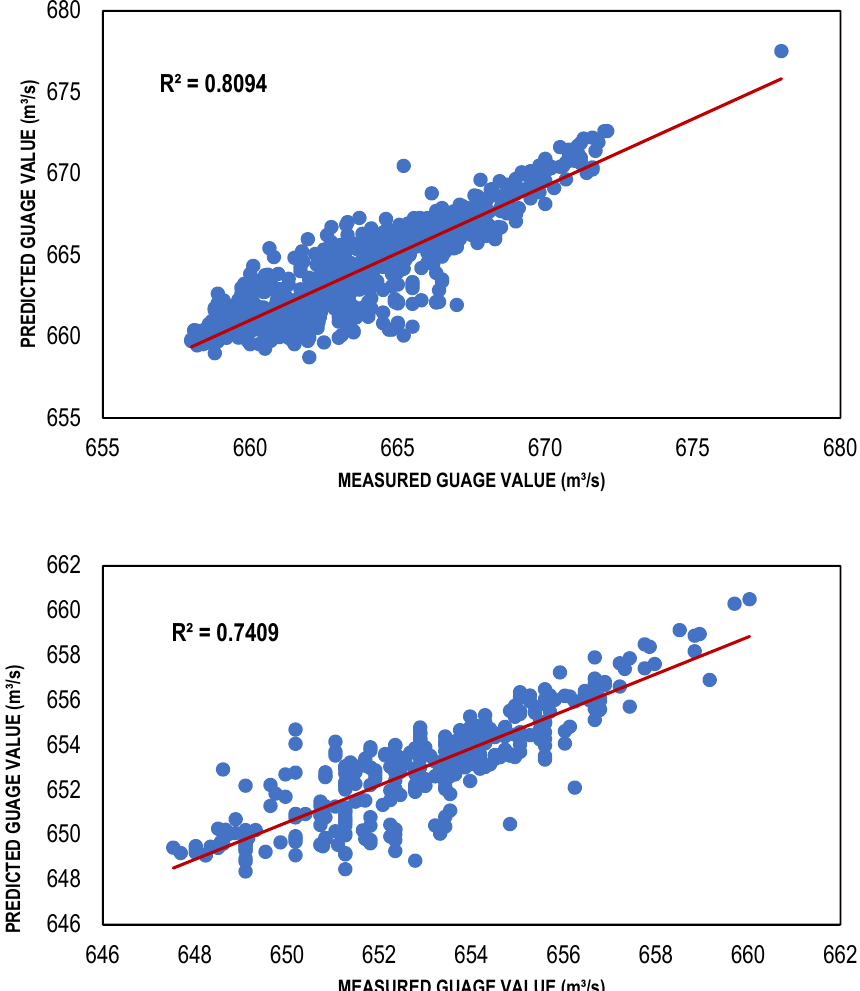
Figure 7. Best CGNN-based models (training and testing).